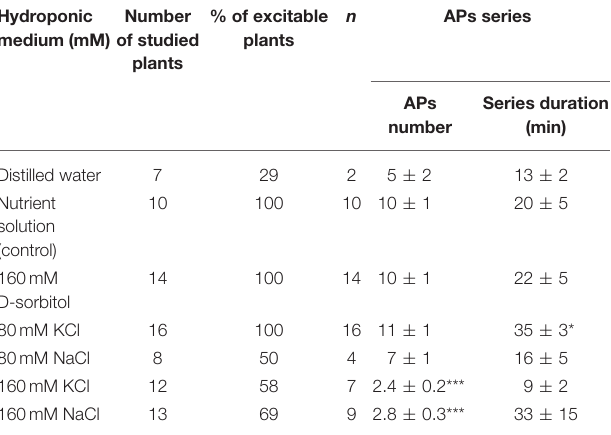
TABLE 2 | Parameters of glutamate induced series of action potentials in Helianthus annuus seedlings growing under osmotic and salt stresses. Hydroponic Number medium (mM) of studied